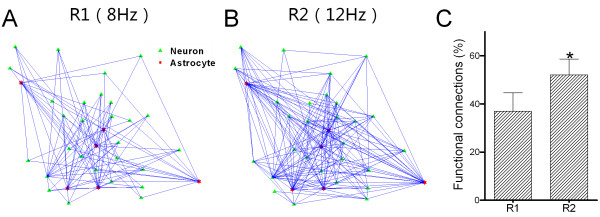
Functional connections between barrel neurons and astrocytes increase in response to stimulus frequencies at 8 Hz and 12 Hz, in which response one (R1) corresponds to 8 Hz and response two (R2) corresponds to 12 Hz. A ~ B) presents the percentages of functional connections (blue lines) between barrel neurons (green symbols) and astrocytes (red) under the conditions of stimulus frequencies at 8 Hz (A) and 12 Hz (B). Scale bar is 20 μm. C) illustrates the percentage of functional connections between barrel neurons and astrocytes in R1 (8 Hz input) and R2 (12 Hz). Asterisk presents p < 0.05 in paied student’s t-test.